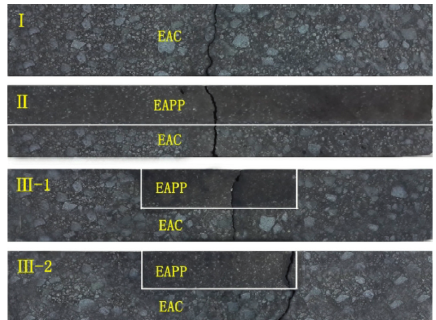
Figure 35: Fatigue failure forms of composite beams [12]. Note: EAC � epoxy asphalt concrete; EAPP � fine-graded epoxy asphalt pavement patching material.